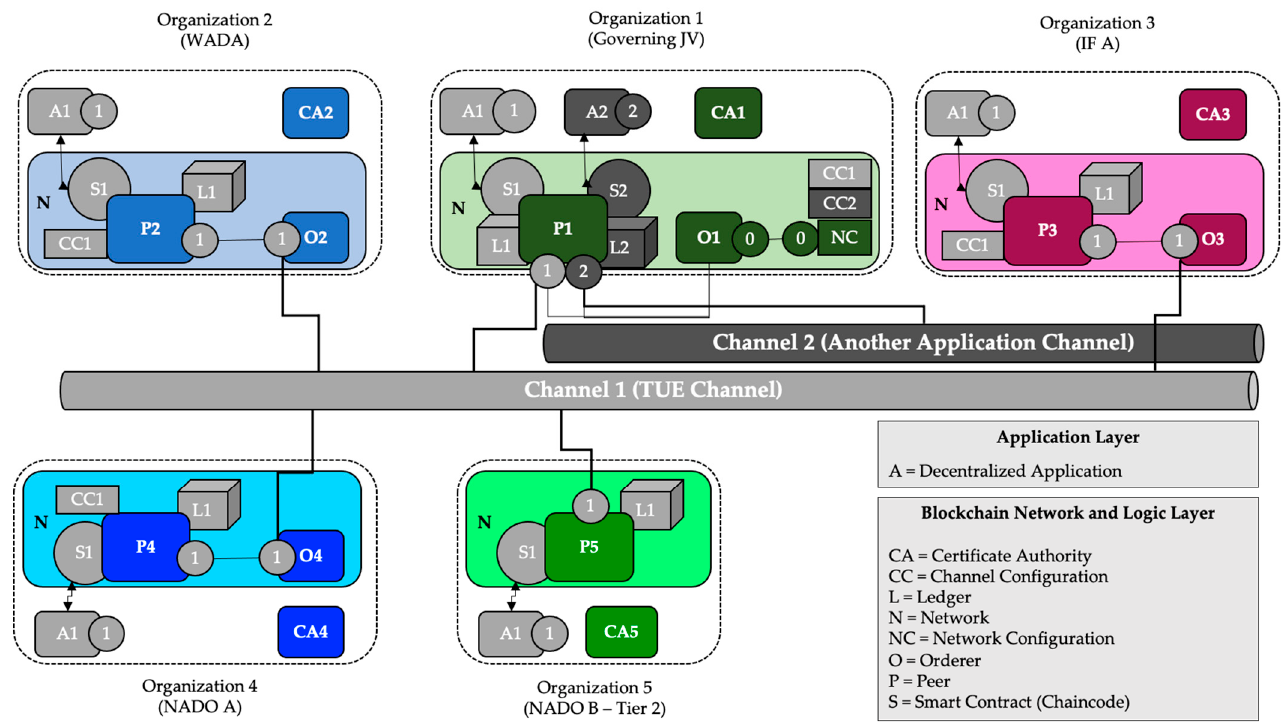
Figure 4. General network architecture for consortium application in HLF, with an example with different channels for different applications. References: [14,74].